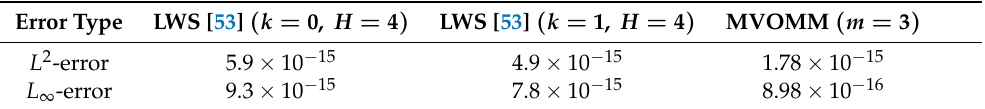
Table 2. Comparison of the strategy used in the present study for Example 1 with distinct errors and the LWS introduced in